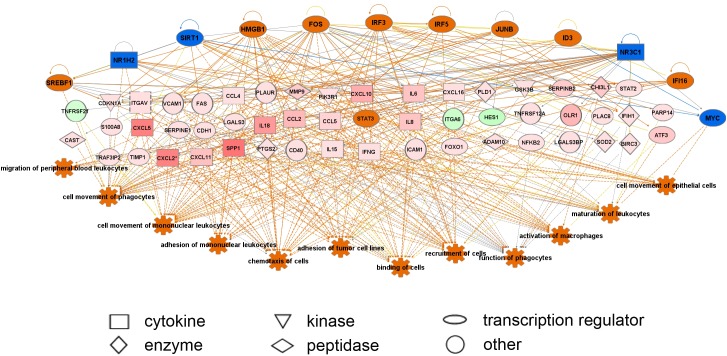
Regulator effect network analysis in IPA identifying altered regulators and networks in granulosa cells cultured in vitro.Orange and blue are predicted up and down regulated regulators on top, and the pink and green represent up and down regulated genes from the array data with the intensity of colour reflecting the degree of change. The pathways altered are listed at the bottom and orange indicates they are up regulated in vitro.